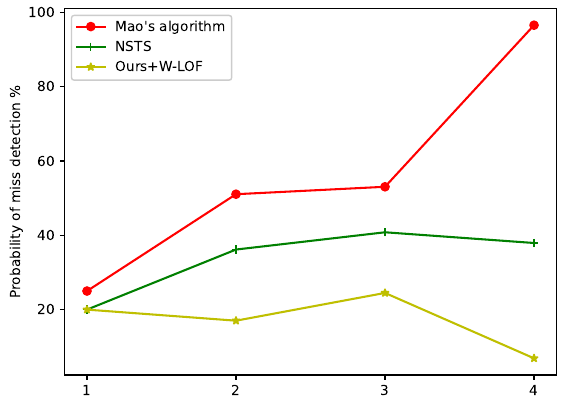
Figure 14. Comparison of the probability of the miss detection. One to four are star images in Figure 11